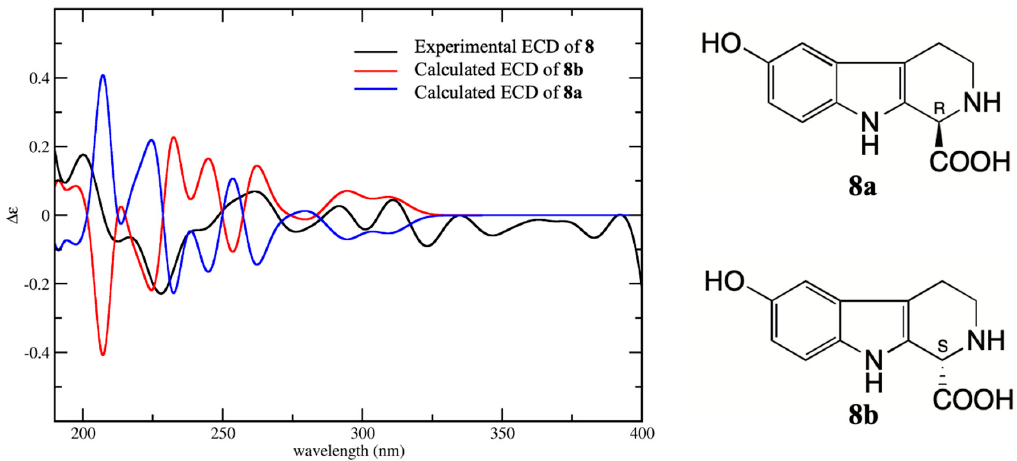
Figure 5. Experimental CD spectrum of 8 in H 2 O and the calculated ECD spectra of (1 R )-8 ( 8a ) and (1 S )-8 ( 8b